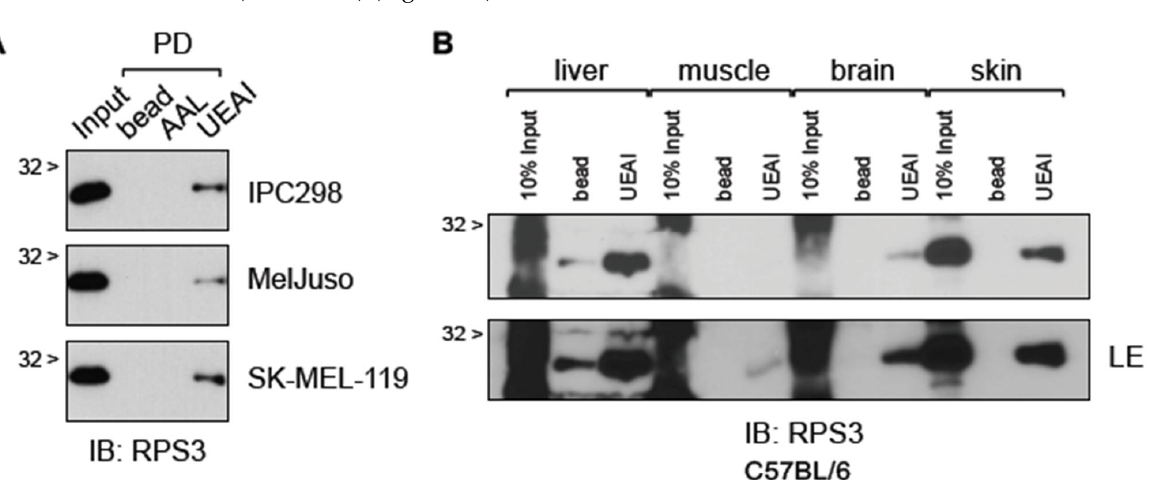
Figure 2. RPS3 is fucosylated in vitro and in vivo. ( A ) RPS3 is recognized by UEAI lectin by agarose-bound lectin pull- down (PD). Cell lines IPC298, MelJuso, and SK-MEL-119 were cultured in growth media and harvested for protein lysate. Lysates were incubated with bead (agarose bead control), AAL (AAL-agarose), or UEAI (UEAI-agarose) to bind fucosyl- ated proteins. UEAI-recognized RPS3 in all three cell lines. ( B ) Liver, muscle, brain, and skin samples were harvested from a C57BL/6 mouse and lysed using a Dounce homogenizer. Lysates were subjected to UEAI PD to isolate UEAI-recognized proteins. RPS3 was recognized by UEAI in all tissue types. LE: long exposure. ( C ) Cells transduced and selected with lentivirus containing Cas9/no guide (ng) or Cas9/sgSLC35C1 (gC1) were grown in normal growth media and harvested